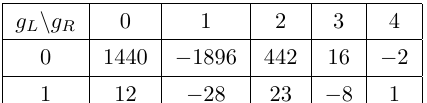
) = (1 , 1 , 1) in E , d 2 , d 3